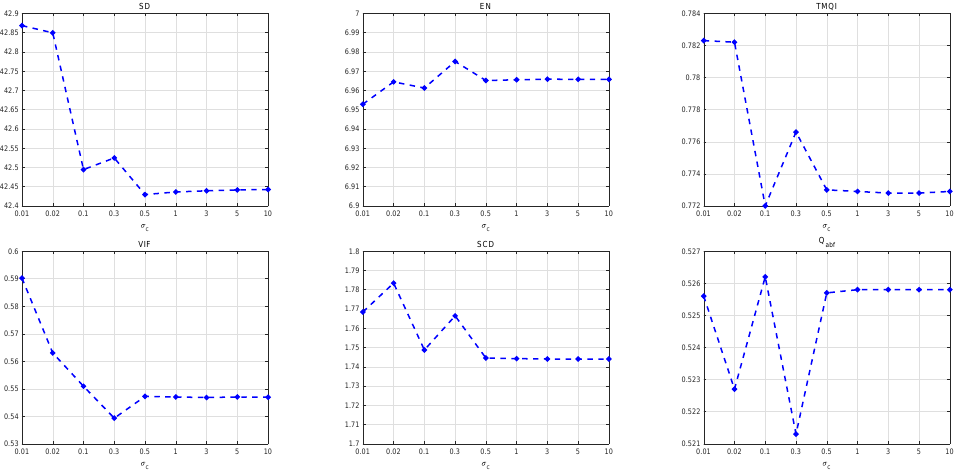
Figure 5. Influence of the parameter σ c on the objective metrics. The average values of each metric are obtained by testing the 21 image pairs. From left to right, σ c = 0.01, 0.02, 0.1, 0.3, 0.5, 1, 3, 5, 10.